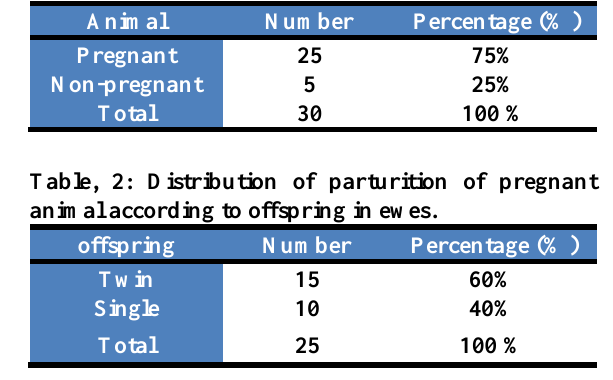
Table, 1: Distribution of study according to pregnant and non-pregnant in ewes.